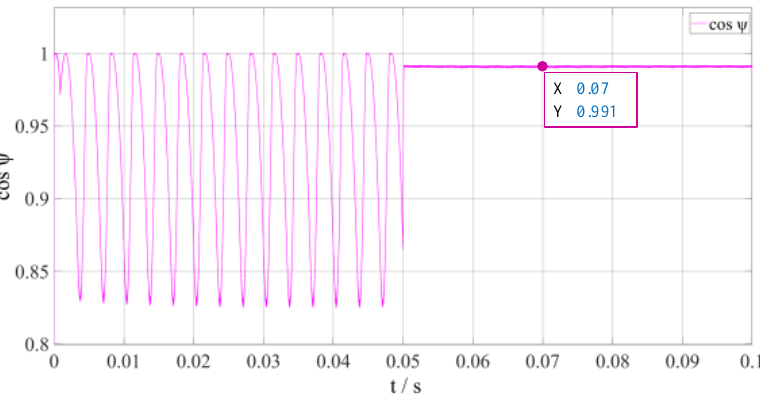
Figure 18. Mode 2 grid-connected power factor.